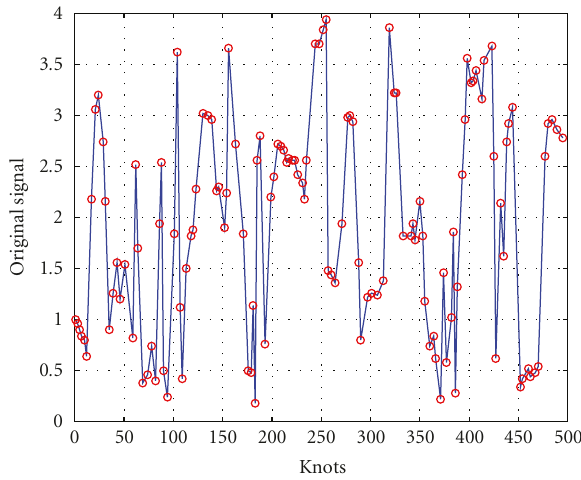
Figure 9: Original discrete signal irregularly spaced “o”.